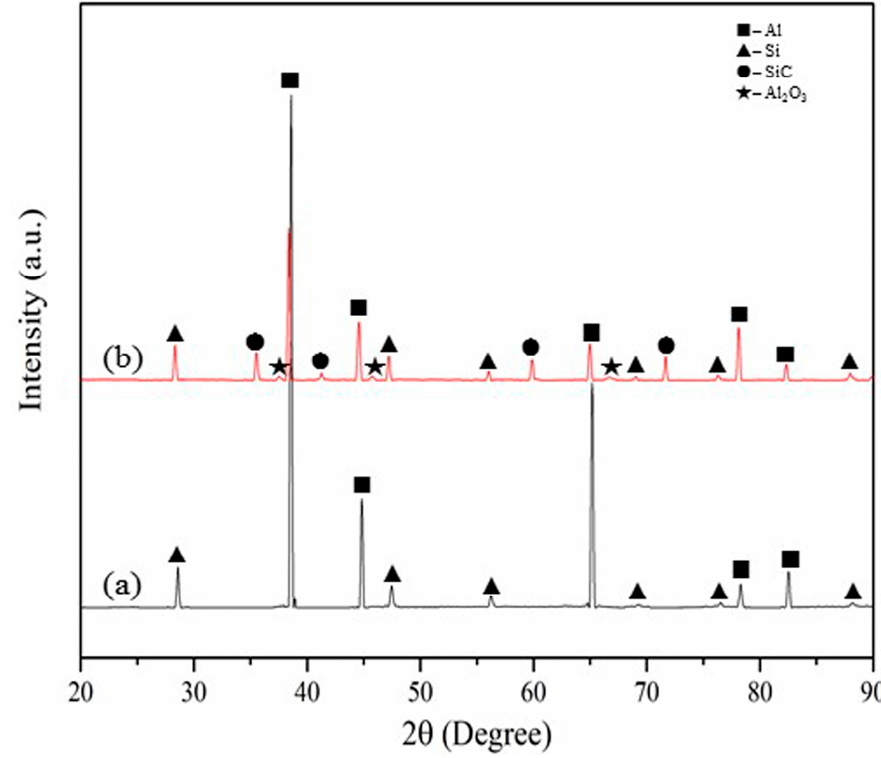
Figure 4. X-ray Diffractometer (XRD) patterns of ( a ) matrix alloy; ( b ) 2wt.%Al 2 O 3np /SiC np /Al composite.